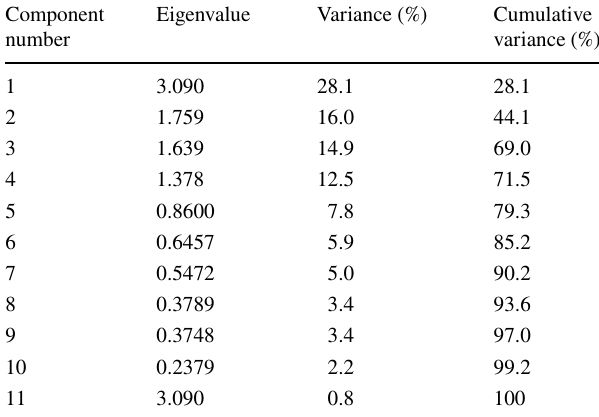
Table 2 Principal component analysis of standardized